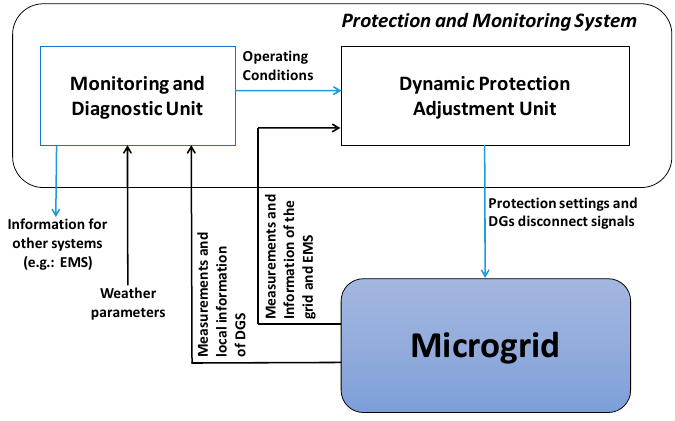
Figure 1. Proposed protection and monitoring system for microgrids.